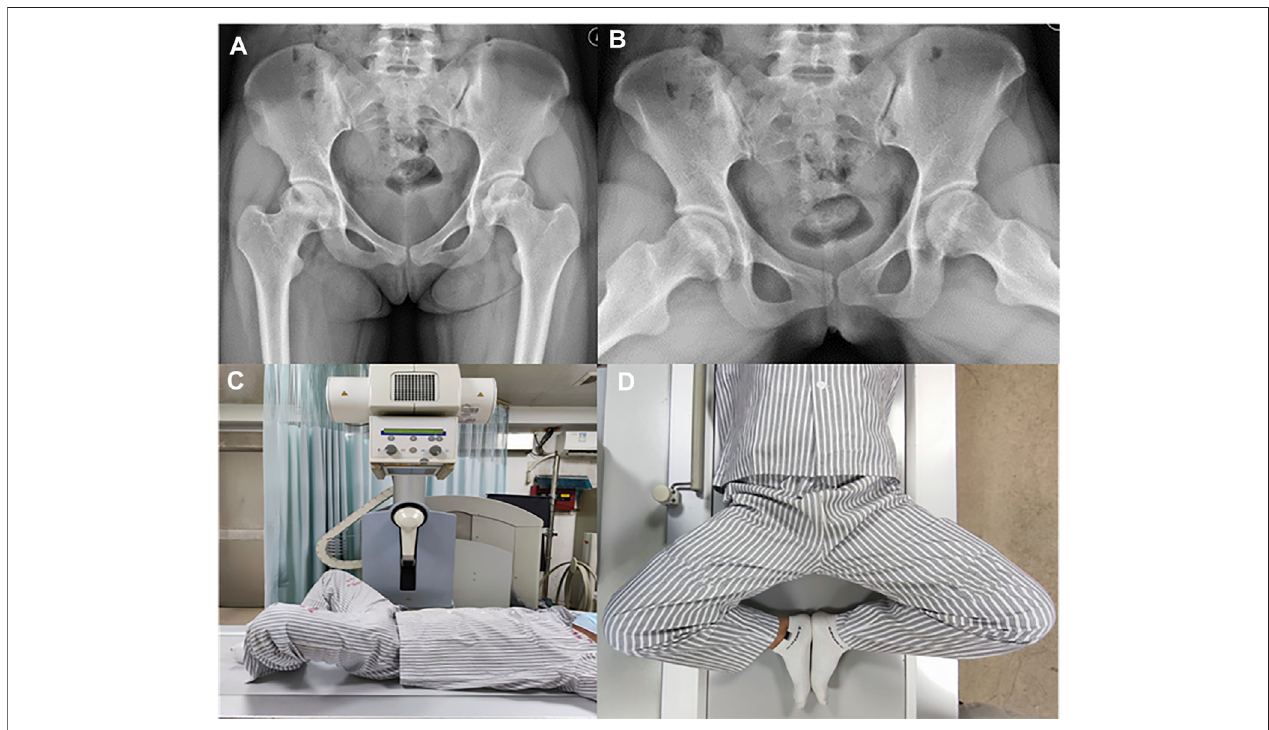
FIGURE 3 | Radiological assessment (A) AP view of hip joint. Patients were positioned supine on the x-ray table and bilateral legs abducted in neutral position so that the distancebetween thetwo feet is equal toshoulder width. (B) FLL view ofhip joint. (C) For the FLL x-rays, patients were positioned supineon the x-ray table and thebilateralhipswere fl exedatadegreeof30 ° . (D) FortheFLLx-rays,thethighwasabductedandexternallyrotatedwhileensuringthatthefeetcontactedclosetoeach other at the level ofipsilateral knee. Thex-ray beam wasdirected anterior to posterior and centered onthe femoralhead whilethe plane ofthe pelvis wasparallelto the plane of the table (Wei QS. et al.,